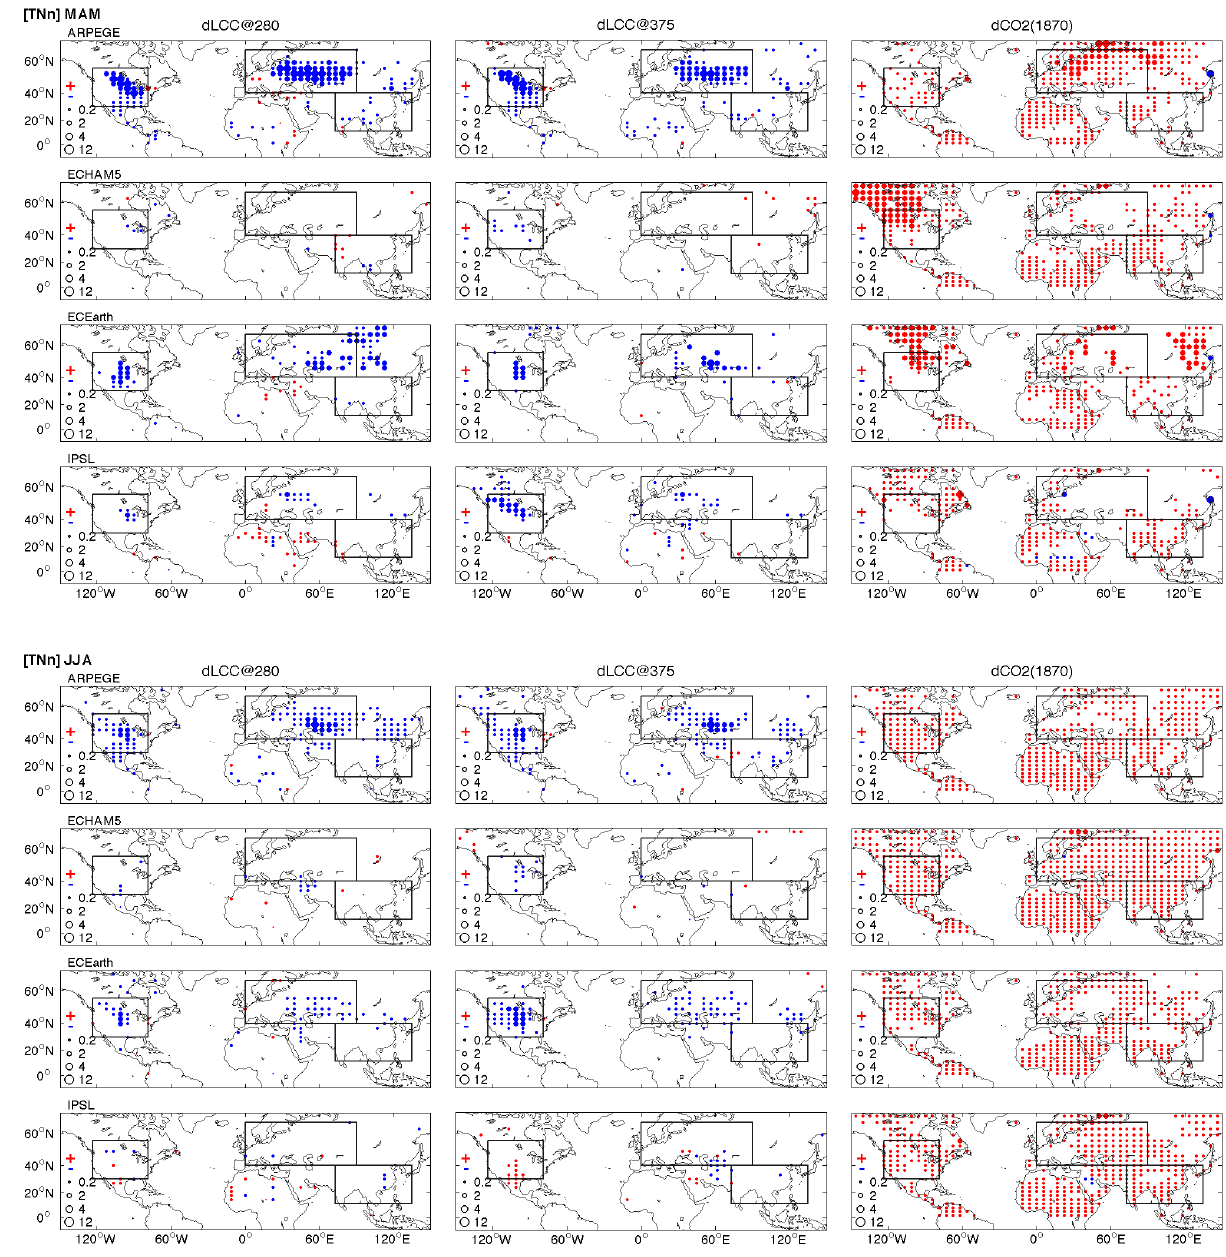
Fig. 5. As Fig. 4 but for the coldest seasonal daily minimum temperature (TNn, ◦ C).